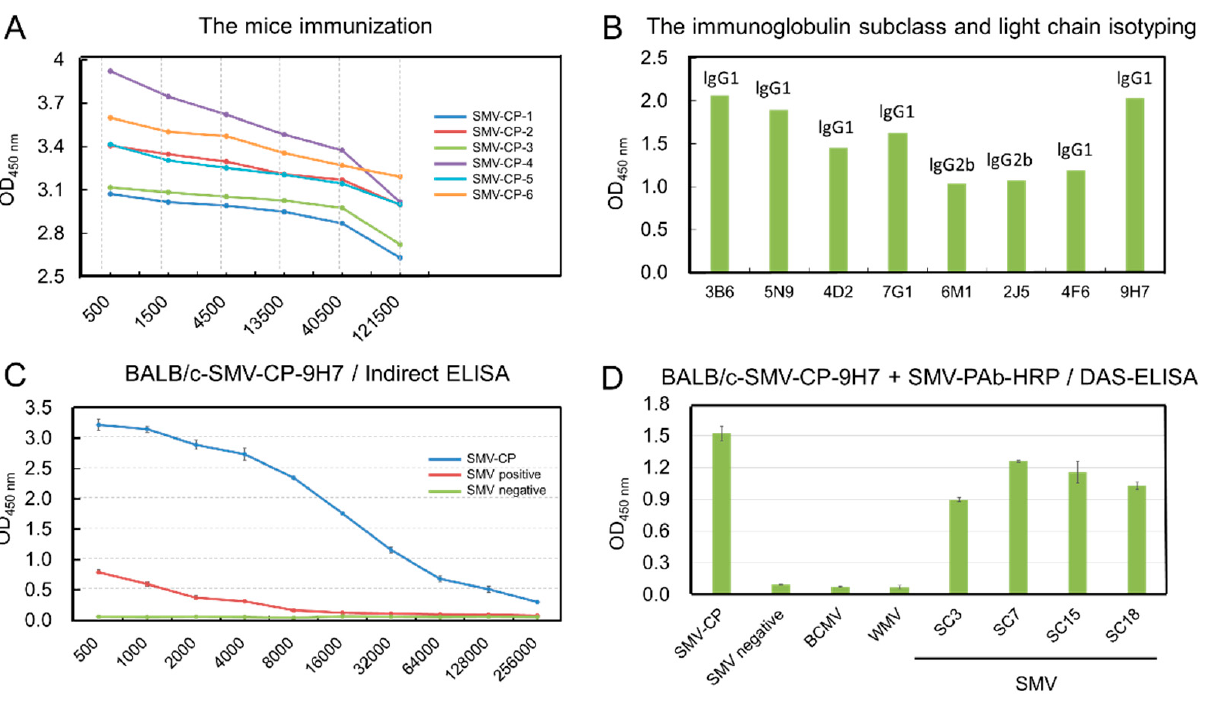
Figure 6. Development and characterization of SMV-CP specific MAb. ( A ) The titer of antiserum against SMV-CP recombinant protein was determined via indirect ELISA; ( B ) the immunoglobulin subclass and light chain isotyping of the SMV-CP-specific MAbs; ( C ) the titer of the purified Mab BALB/c-SMV-CP-9H7 was detected via indirect ELISA; ( D ) specificity tests of the BALB/c-SMV-CP- 9H7 for SMV detection was determined via DAS-ELISA.2.6. Controlled Test and Field Application of the SMV-GICS.